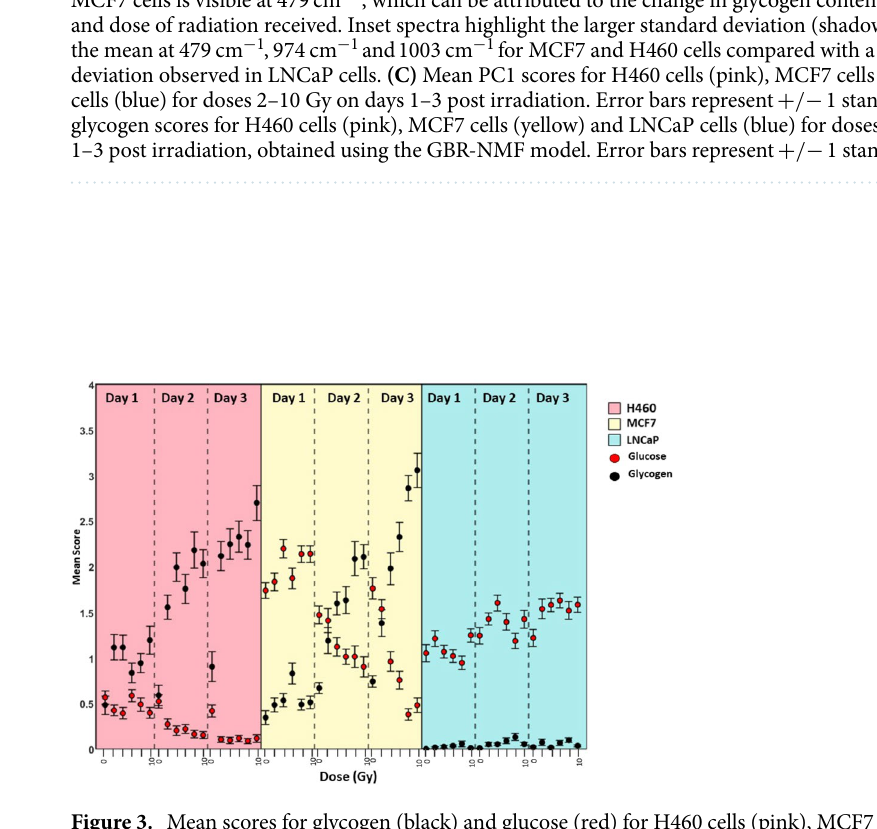
Figure 3. Mean scores for glycogen (black) and glucose (red) for H460 cells (pink), MCF7 cells (yellow) and LNCaP cells (blue) for doses 2–10 Gy on days 1–3 post irradiation, obtained using the GBR-NMF model. Error bars represent + / − 1 standard